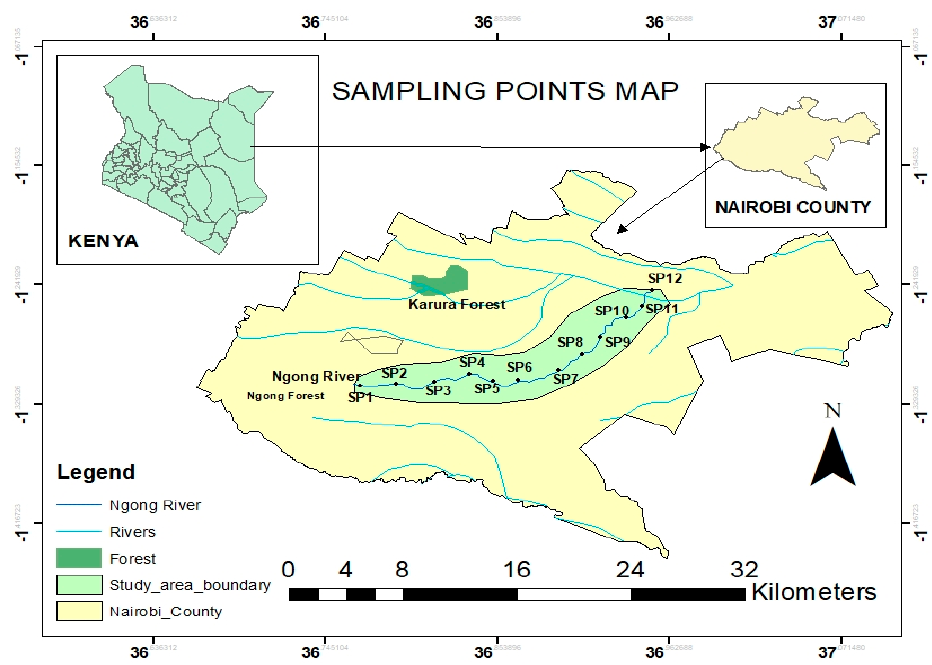
Figure 1. Map showing Ngong River locality in Nairobi County and sampling points.